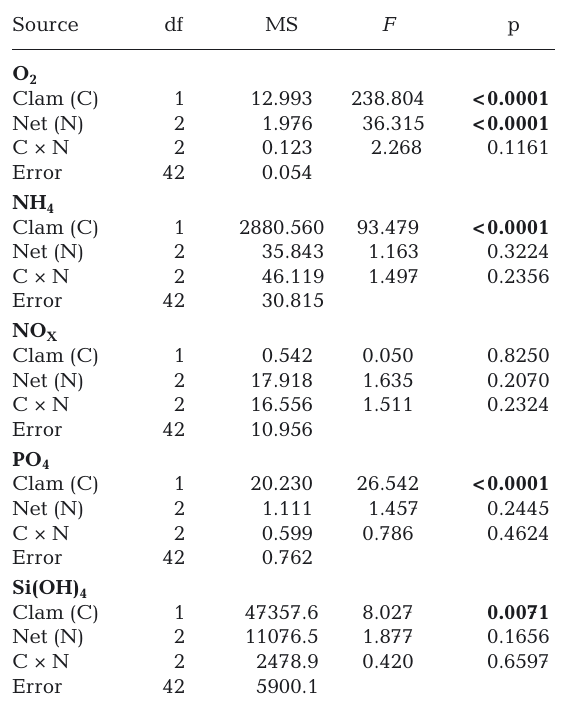
Table 3. Results of 2-way ANOVAs evaluating the effect of Clam (presence/absence) and Net status (fouled, cleaned, or absent) on biogeochemical fluxes: O 2 , NH 4 , NO X , PO 4 , and